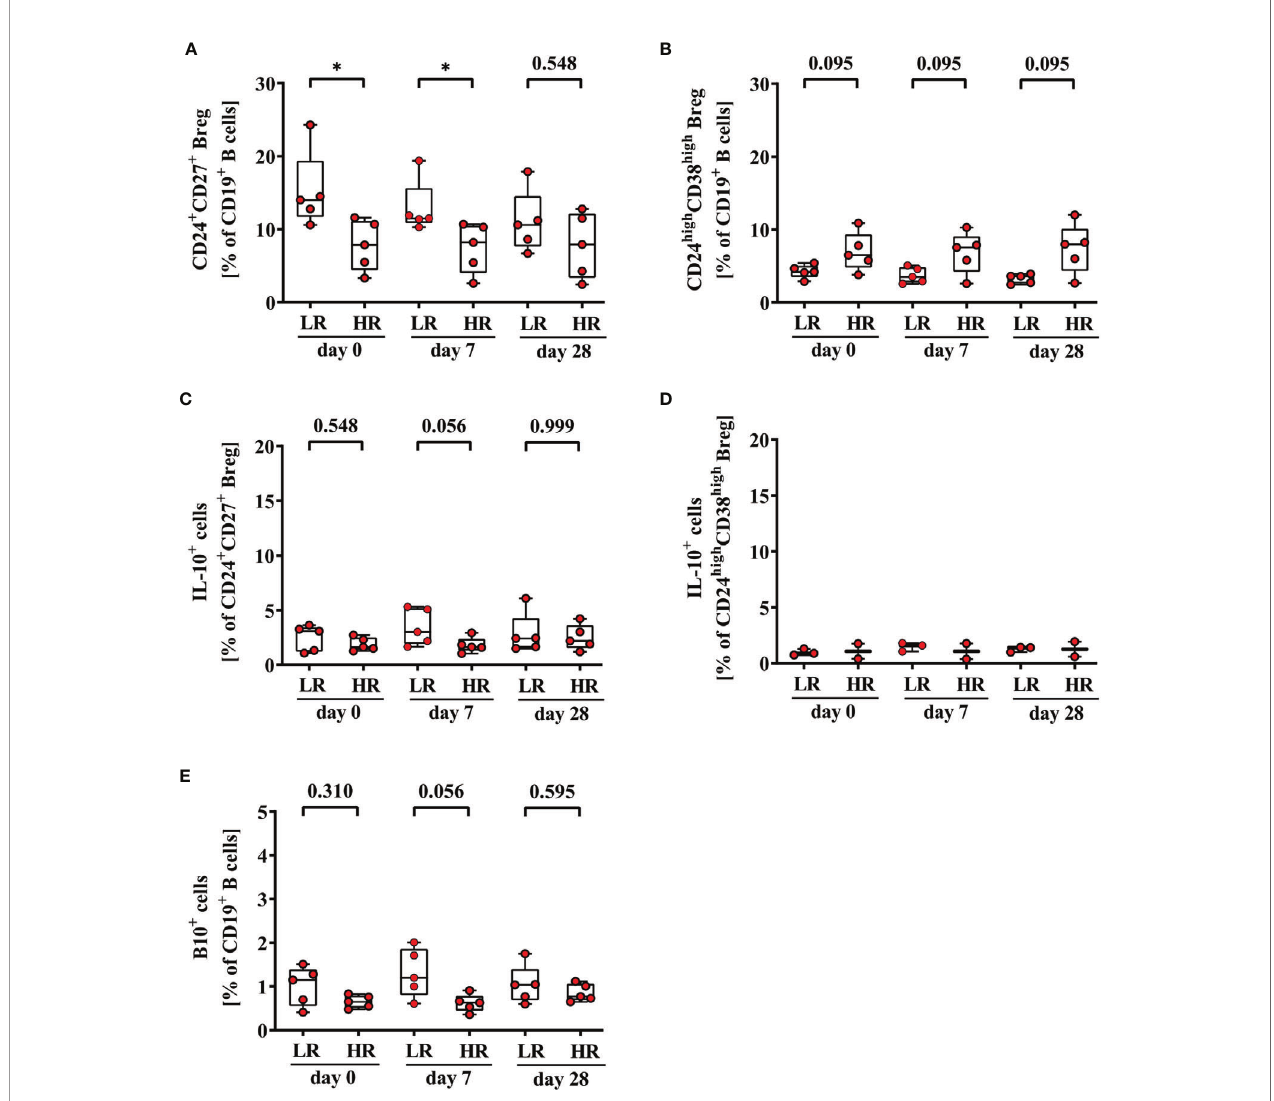
FIGURE 5 | Frequencies of CD24 + CD27 + (A) , CD24 high CD38 high (B) , CD24 + CD27 + IL-10 + (C) , CD24 high CD38 high IL-10 + Breg (D) , and CD19 + IL-10 + B (B10 + ) cells (E) of third-generation hepatitis B vaccine low- and high-responders. Depicted are (CpG+P/I)-induced frequencies of CD24 + CD27 + (A) , CD24 high CD38 high (B) , CD24 + CD27 + IL-10 + (C) , CD24 high CD38 high IL-10 + Breg (D) and CD19 + IL-10 + B (B10 + ) cells (E) of third-generation hepatitis B vaccine low- (LR) and high-responders (HR) (red circles, n = 5, respectively) before (day 0) and 7, and 28 days after vaccination with a third-generation hepatitis B vaccine. The boxes show the median and the 25 th and 75 th percentile. Whiskers indicate the highest and lowest values. Statistical analyses are based on unpaired Mann-Whitney U tests. * p <